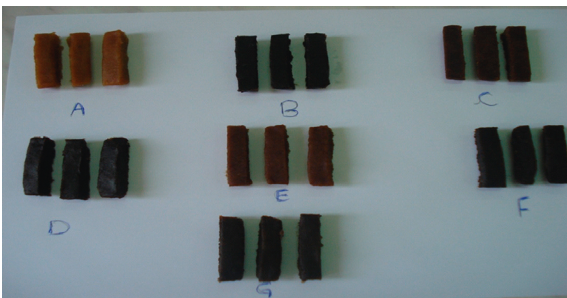
Figure 2: Physical aspect of obtained candy samples. See Table 1 for composition of